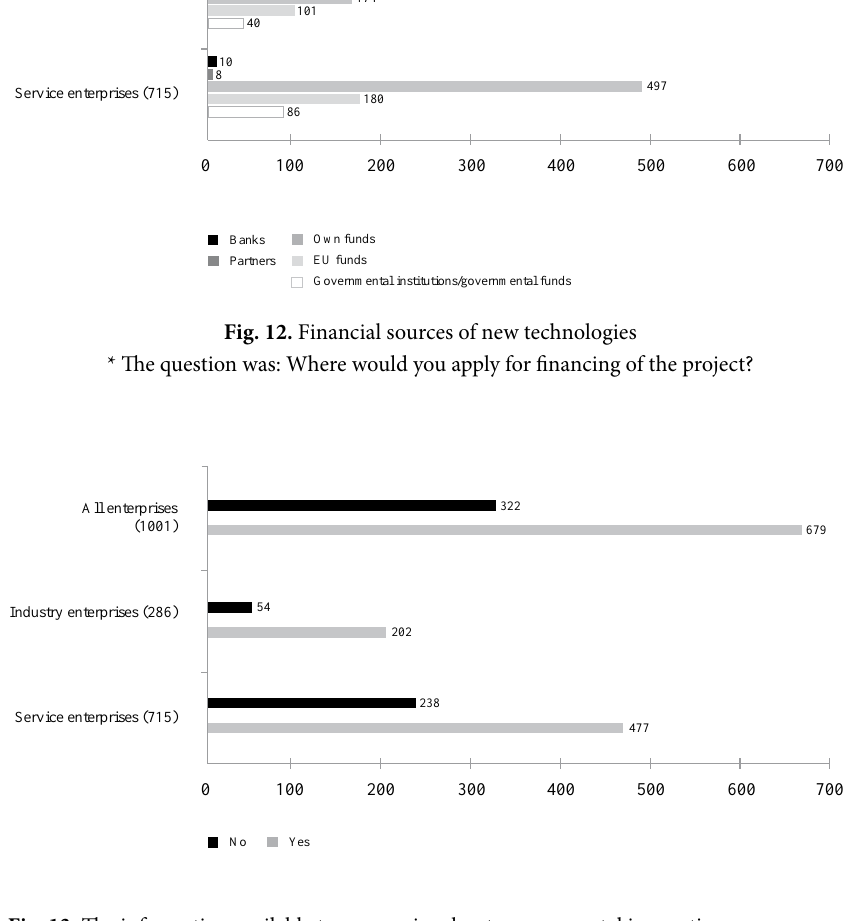
fig. 13. The information available to companies about governmental innovations